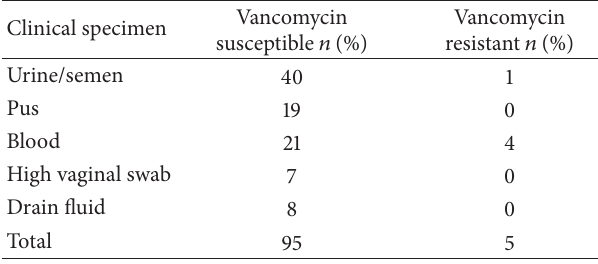
Table 4: Pattern of vancomycin susceptibility in Enterococcus spp.